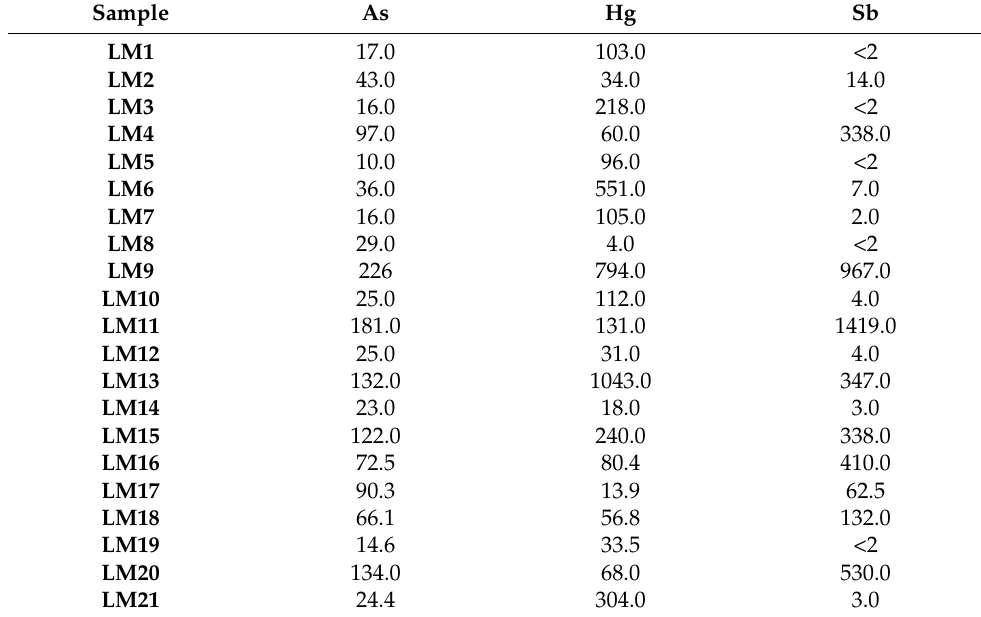
Table 3. Concentrations of As, Hg, Sb (mg kg − 1 ) in the studied